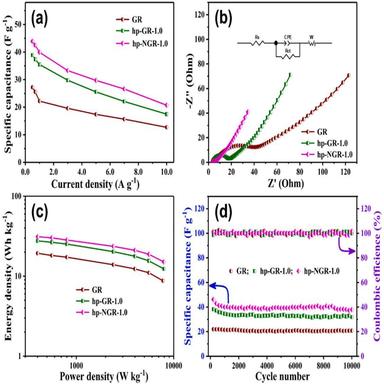
Rate capabilities (a), Nyquist plots (b), Ragone plots (c) and cycling performance (d) of the GR, hp-GR-1.0 and hp-NGR-1.0 based symmetrical devices.